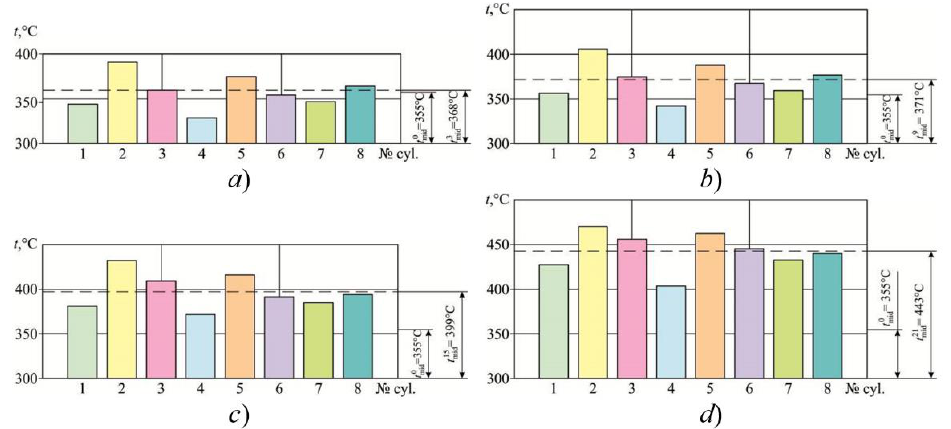
Figure 13. Change in exhaust gas temperature in the cylinders of a 16V32 STX-MAN marine diesel engine at different values of the degree of exhaust gas recirculation (load 75%): ( а ) δ EGR = 3%; ( b ) δ EGR = 9%; ( c ) δ EGR = 15%; ( d ) δ EGR = 21%.